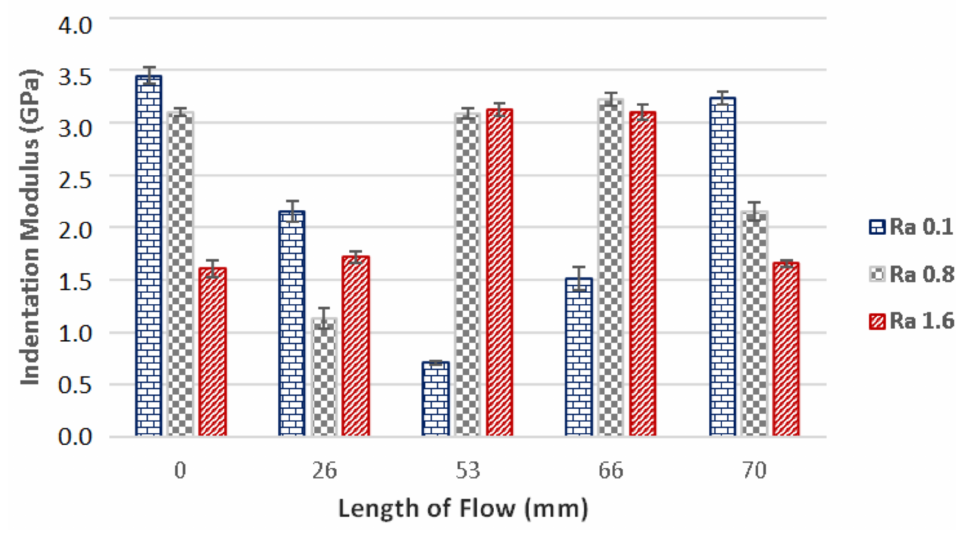
Figure 8. The dependence of the flow length on the indentation modulus in cavities with following surface quality: Ra 0.1, Ra 0.8, Ra 1.6 and 800 bar injection